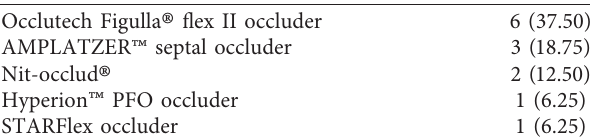
Table 1: Used devices.